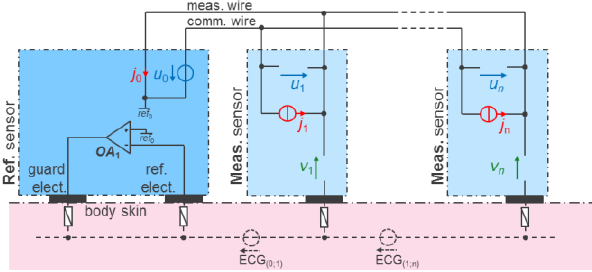
Figure 3. Communication principle of cooperative sensors